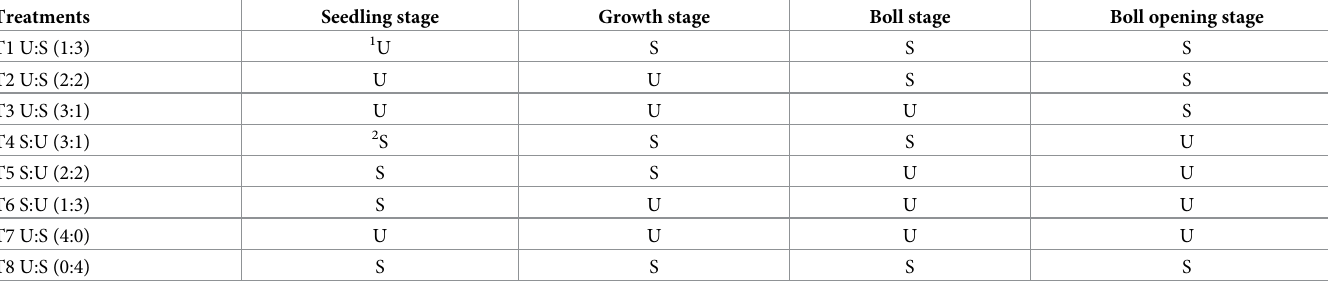
Table 3. Supply of surface and underground water at different growth stage of cotton during round irrigation 2020.